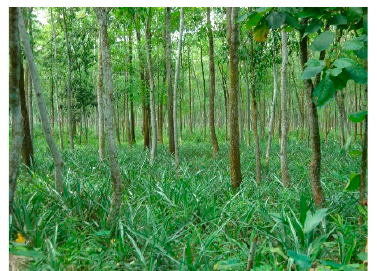
Table 1. Cost of production and income from fast-growing tree and shade-loving crops-based agro- forestry practices.